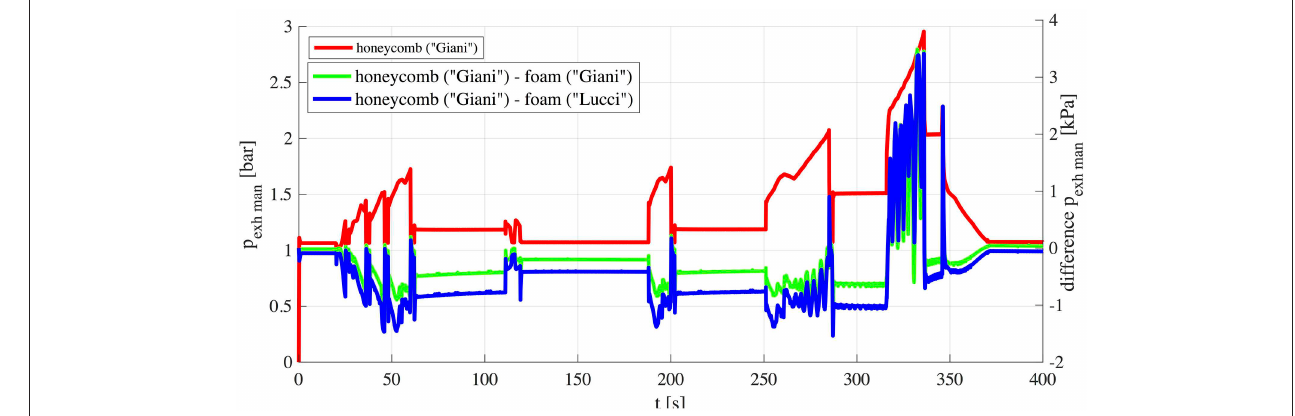
FIGURE 9 | Calculated pressure in the exhaust manifold.